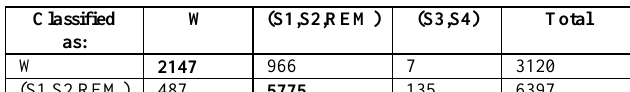
SVM CONFUSION MATRIX WITH UNBALANCED